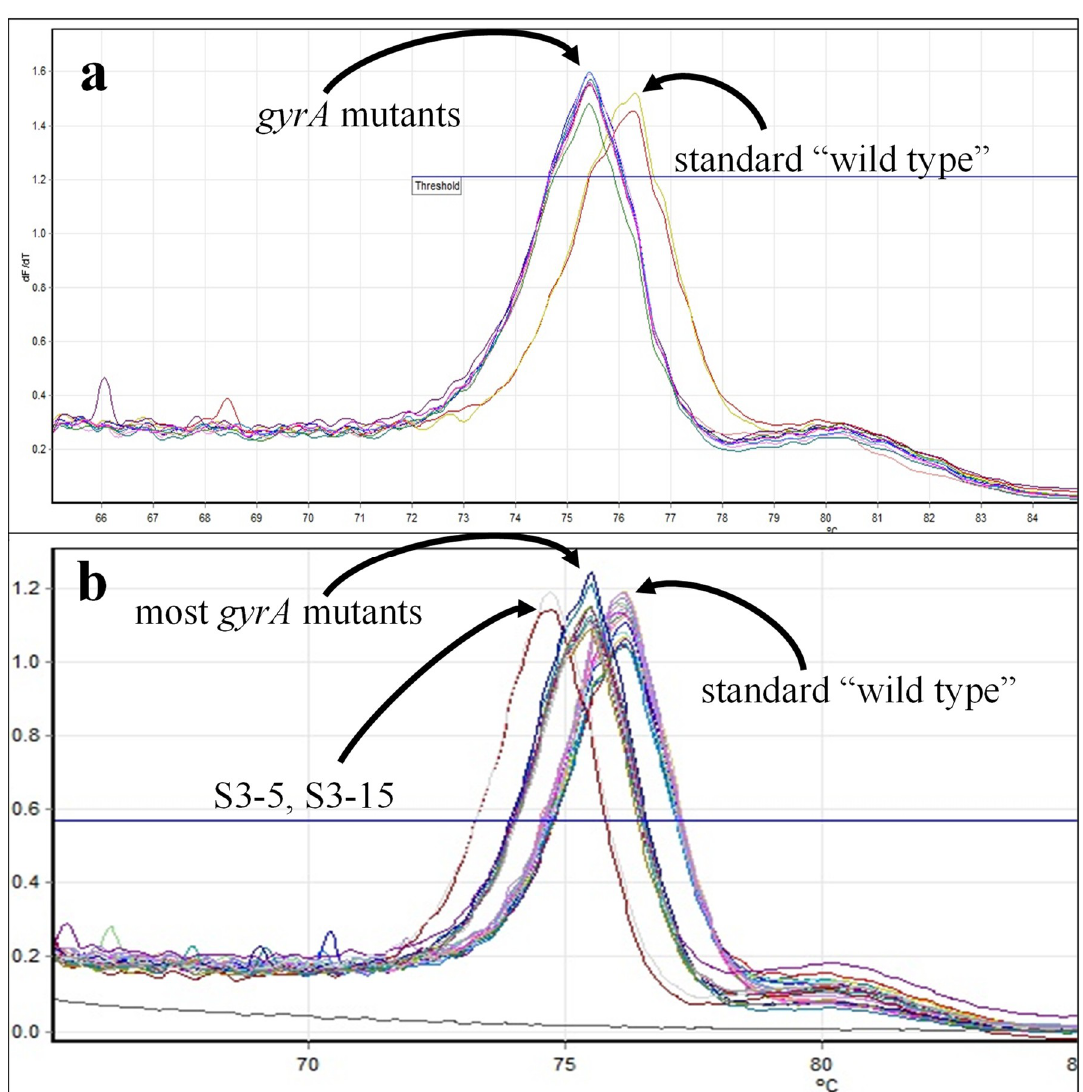
Figure 8. GyrA melt curves for B. anthracis strains. ( a ) Melt curves for wild-type strains, Sterne and ∆ANR, and gyrA -mutated ∆ANR strains, S1-1, S1-2, S2-1, S2-2, S2-3, S3-1, S3-3, and S3-4. ( b ) Melt curves for the remainder of wild-type and gyrA -mutated ∆ANR strains (see Table 6). HRMA and clustering of the same set of B. anthracis samples based on parC sequences were complicated by higher PCR failure rates and a narrower temperature range between T m s of wild-type and mutant amplicons. Furthermore, T m s for control strains could shift from day to day by as much as ◦ 0.5 C, making it di ffi cult to compare samples tested on di ff erent days, other than to indicate that they clustered with (or separate from) specific control samples (see footnote to Table